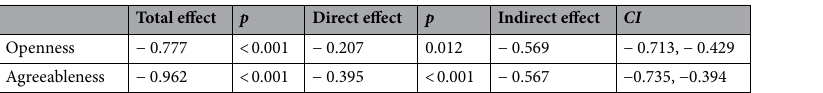
Table 3. Total effect, direct effect, and indirect effect of personality on the desire for social distance. Indirect effect was deemed significant when the confidence interval did not include